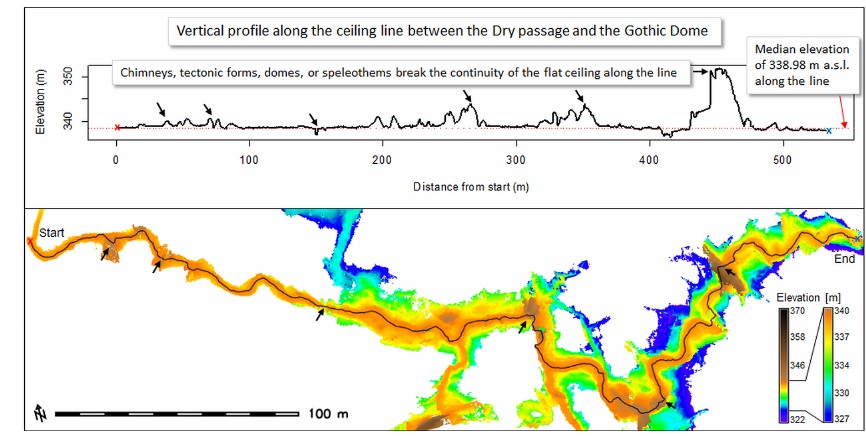
Figure 8. Longitudinal profile along the automatically delineated ceiling line of overlaid on top of the raster DEM_CH.